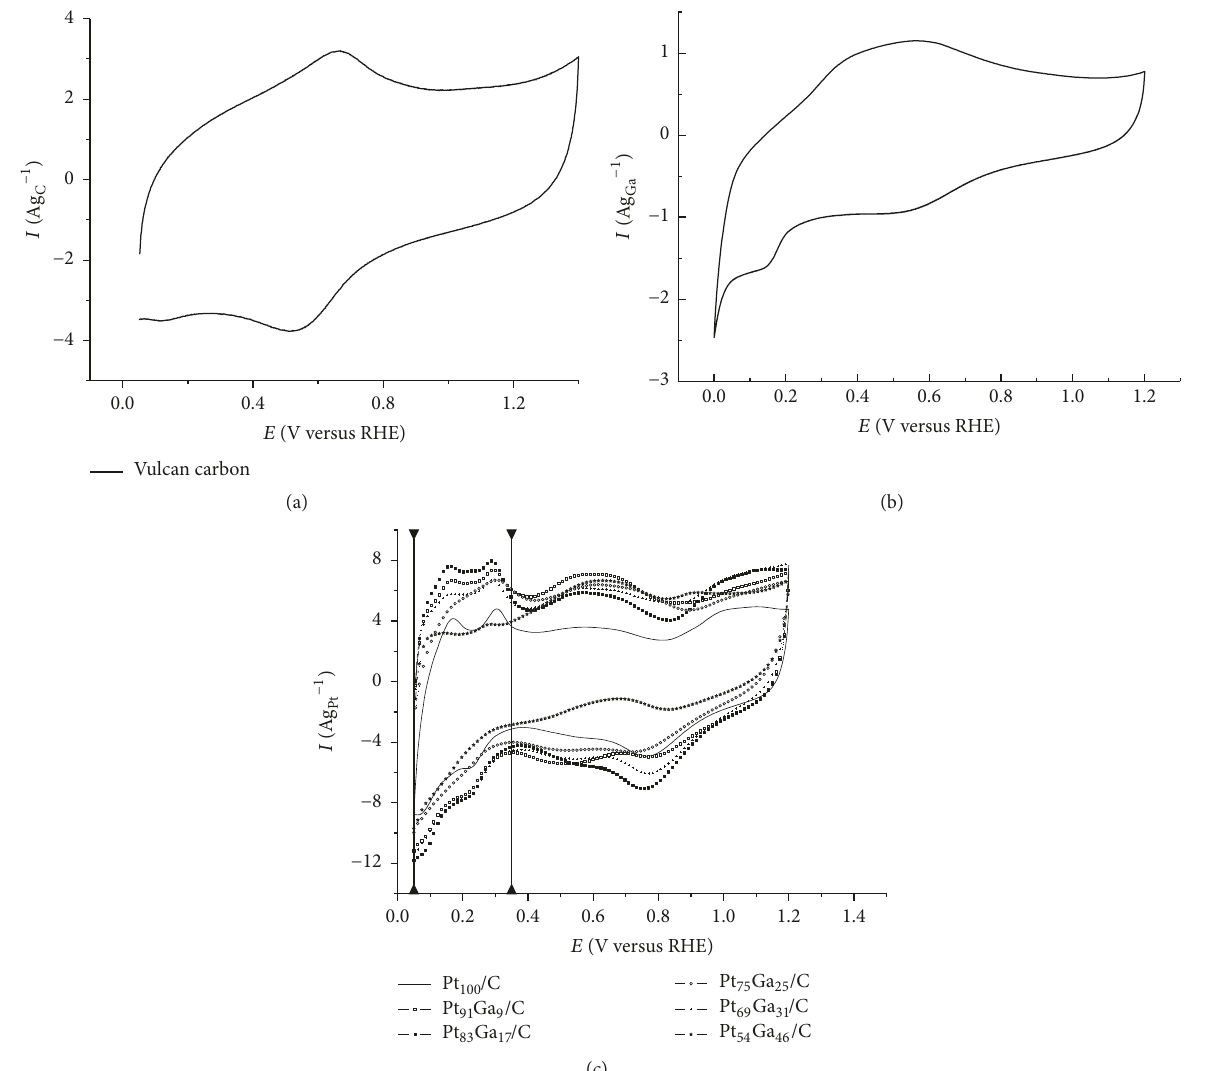
Figure 5: Cyclic voltammograms of the (a) Vulcan carbon XC-72; (b) Ga/C; and (c) PtGa/C electrocatalysts in H 2 SO 4 0.5 molL −1 supporting electrolyte, from 0.05 to 1.2V versus RHE and scan rate of 50 mVs −1 .